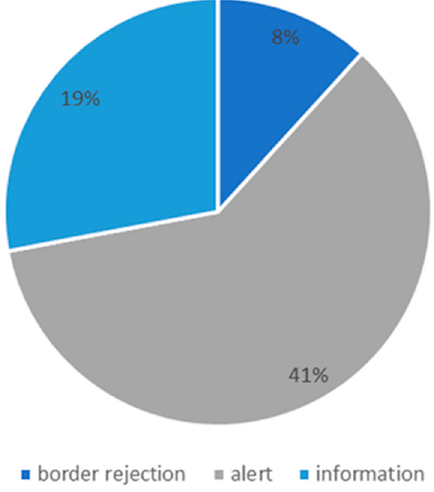
Figure 1. Pet foods and treats notifications of bacterial contamination in the Rapid Alert System for Food and Feed (RASFF) database (2017–2020).